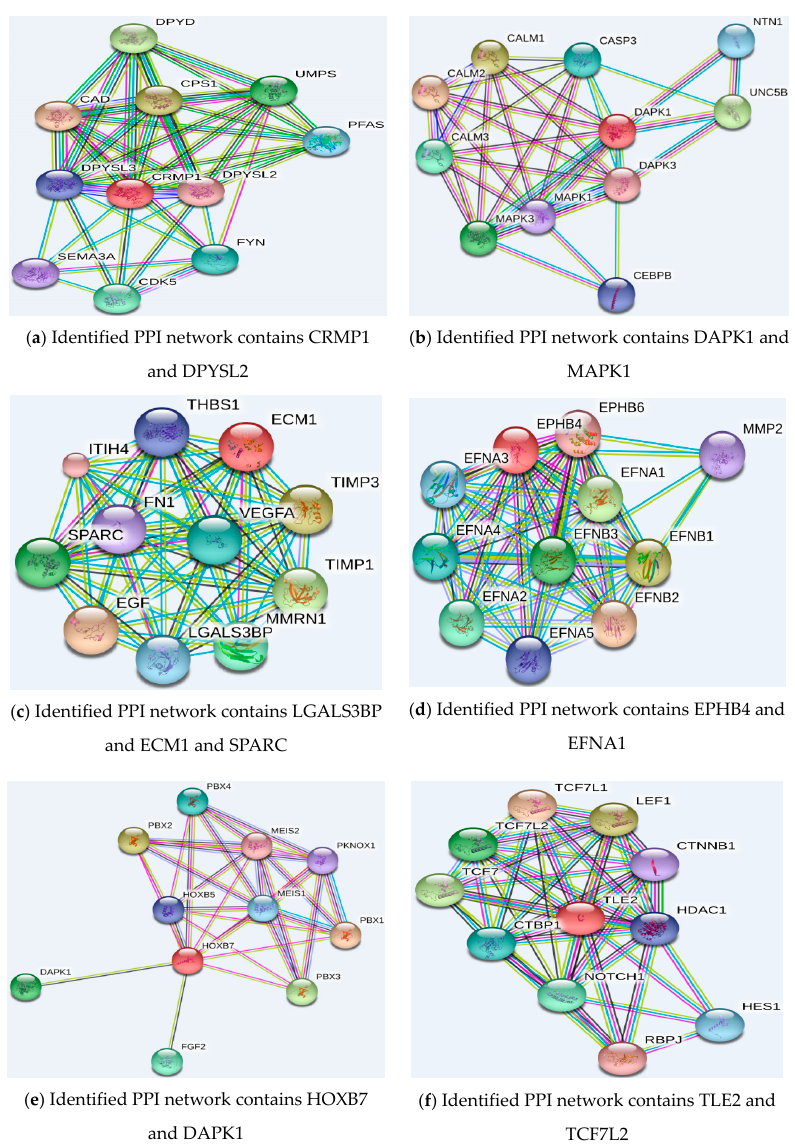
Figure 5. Experimentally identified protein–protein interaction (PPI) network containing the reported genes. Original figures appear in the Supplementary Material.